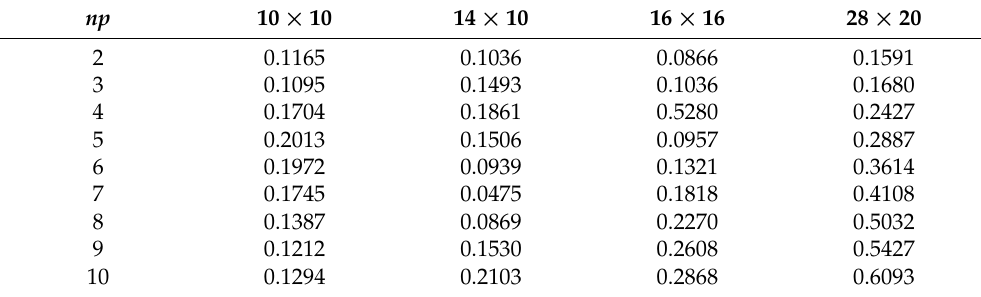
Table 2. Relative L 2 norm of the difference between the horizontal component of the velocity solution, u x , obtained with Legendre collocation with a mesh 50 × 50 in a single domain and the solution obtained with different numbers of subdomains on the horizontal axis, np , two subdomains on the vertical axis, mp = 2, and different Legendre collocation meshes N × M ; R = 1300 and Γ = 3.495. np 10 × 10 14 × 10 16 ×